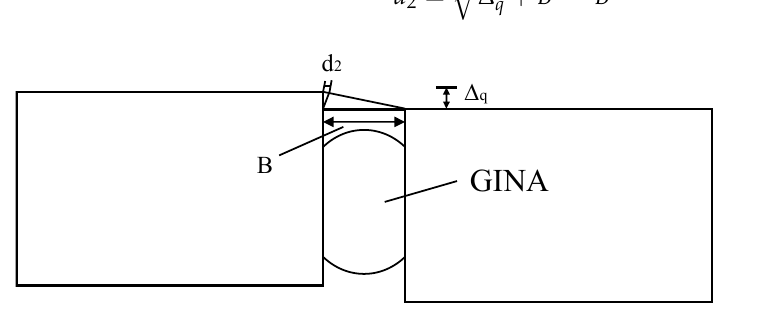
Figure 10. Geometric diagram of shear deformation.